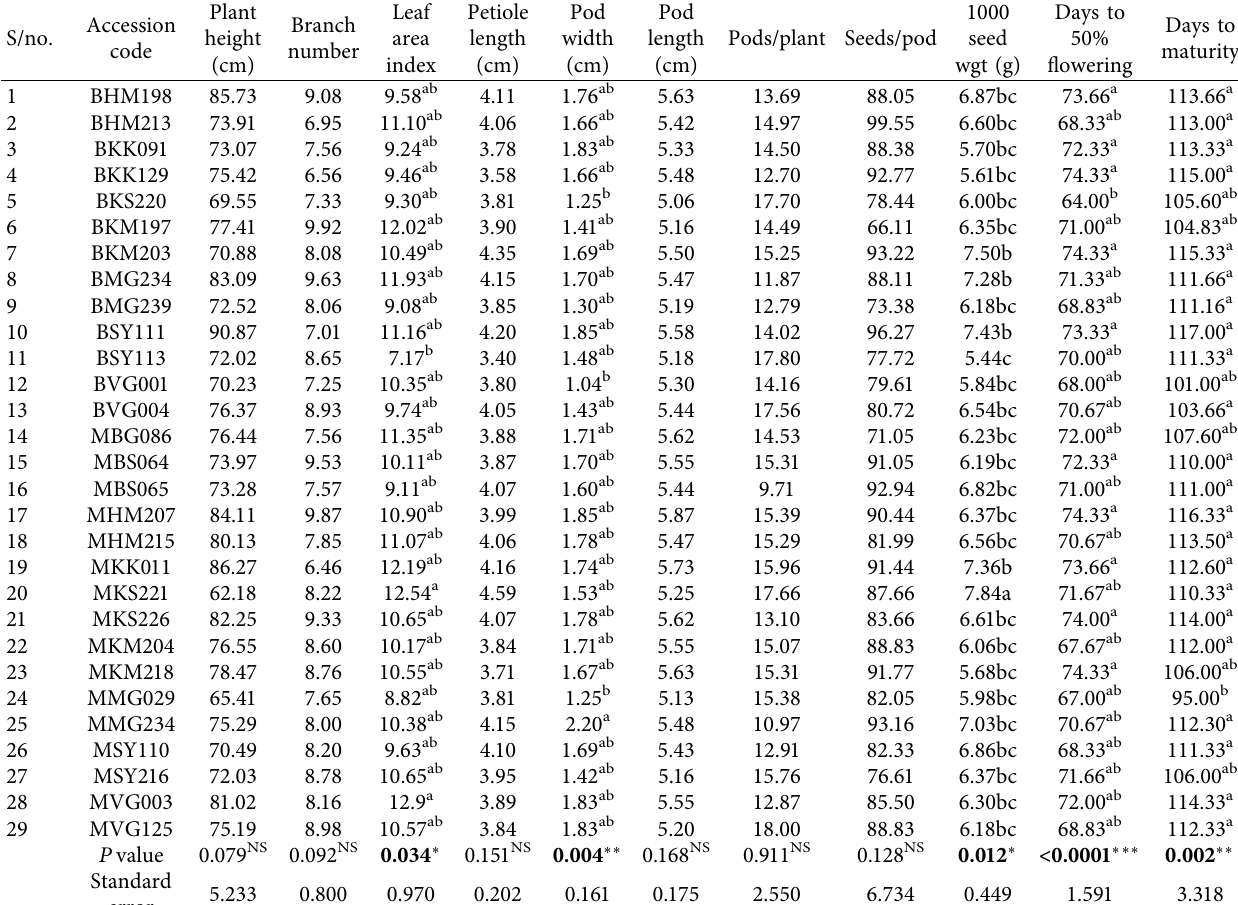
Table 3: Means of quantitative growth and yield variables of selected slender leaf accessions. S/no.